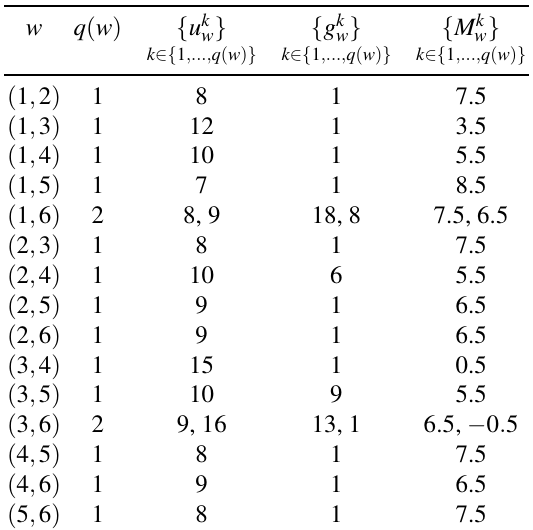
Table 1. Values of { α w ( θ ) } θ ∈ Θ , w ∈ W